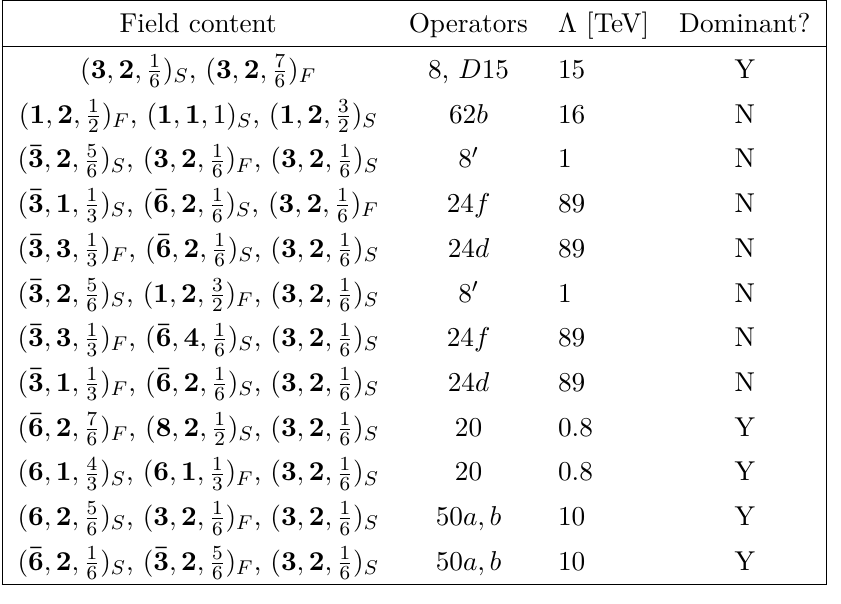
Table 7. The table shows the models in our filtered list that contain fewer than four fields with the estimate of the upper-bound on the new-physics scale Λ in the range 700 GeV < Λ < 100 TeV . Models containing colour sextet fields can be replaced with the corresponding colour-triplet fields with a different baryon-number assignment. The fields and models are listed in no special